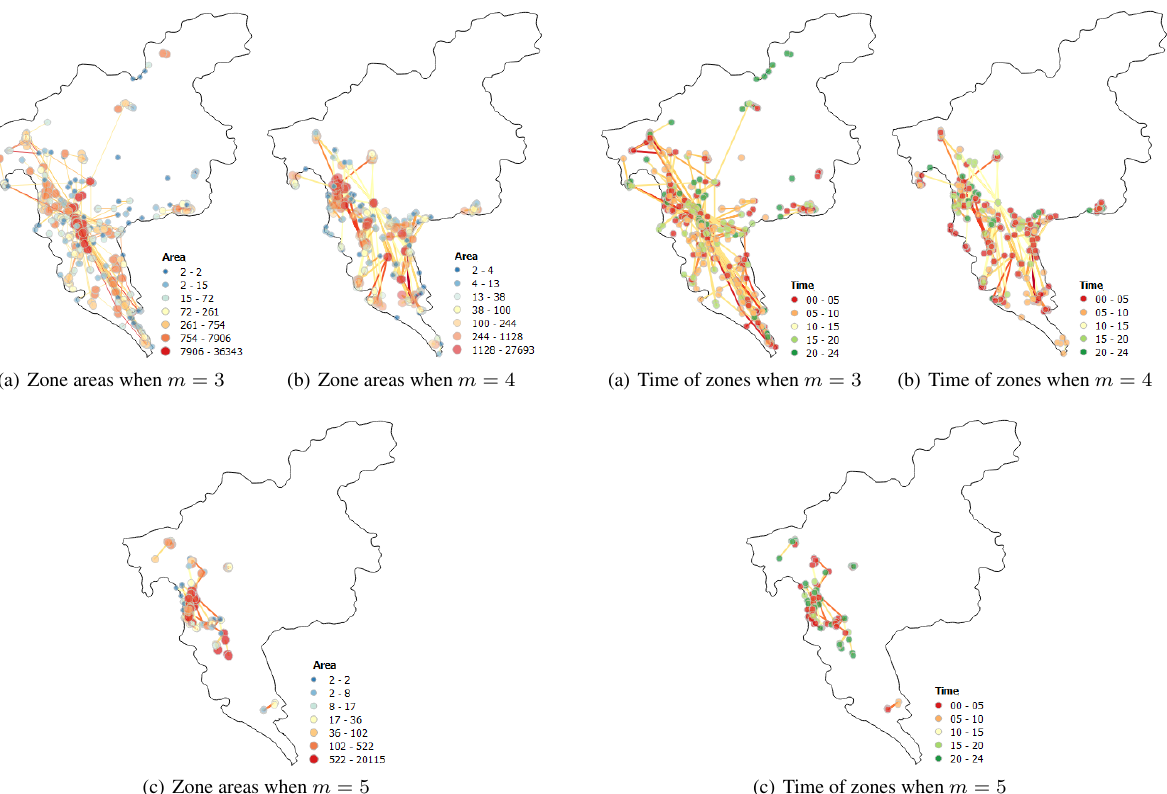
Figure 8. Zone areas of UHIs in different magnitudes associate with their trajectories between July 31 and August 6.